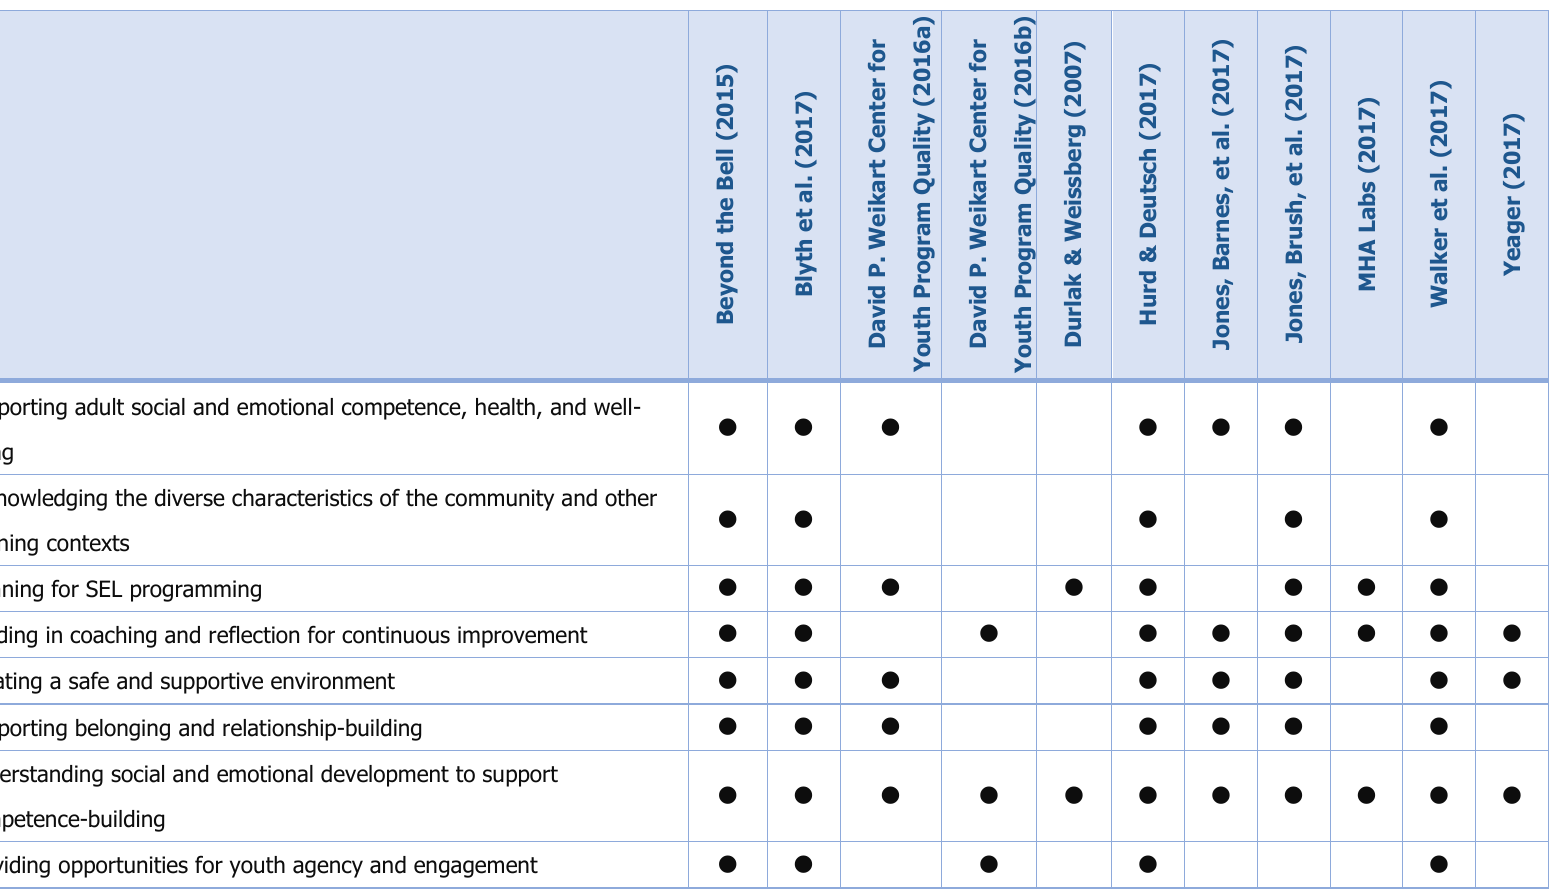
Table 2. Crosswalk of SEL Practice Resources With Eight SEL